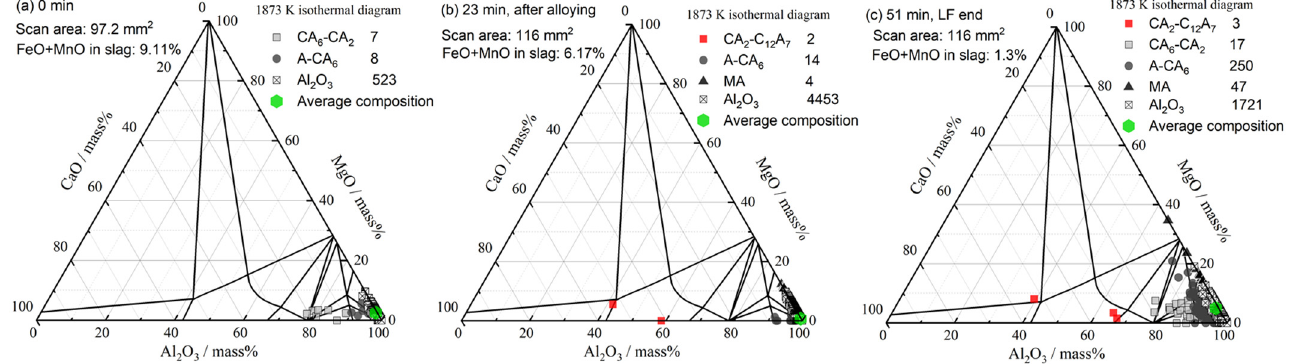
Figure 12. Observed inclusions in heat 1, ( a ) 0 min; ( b ) 23 min, after alloying; ( c ) 51 min, the LF end.